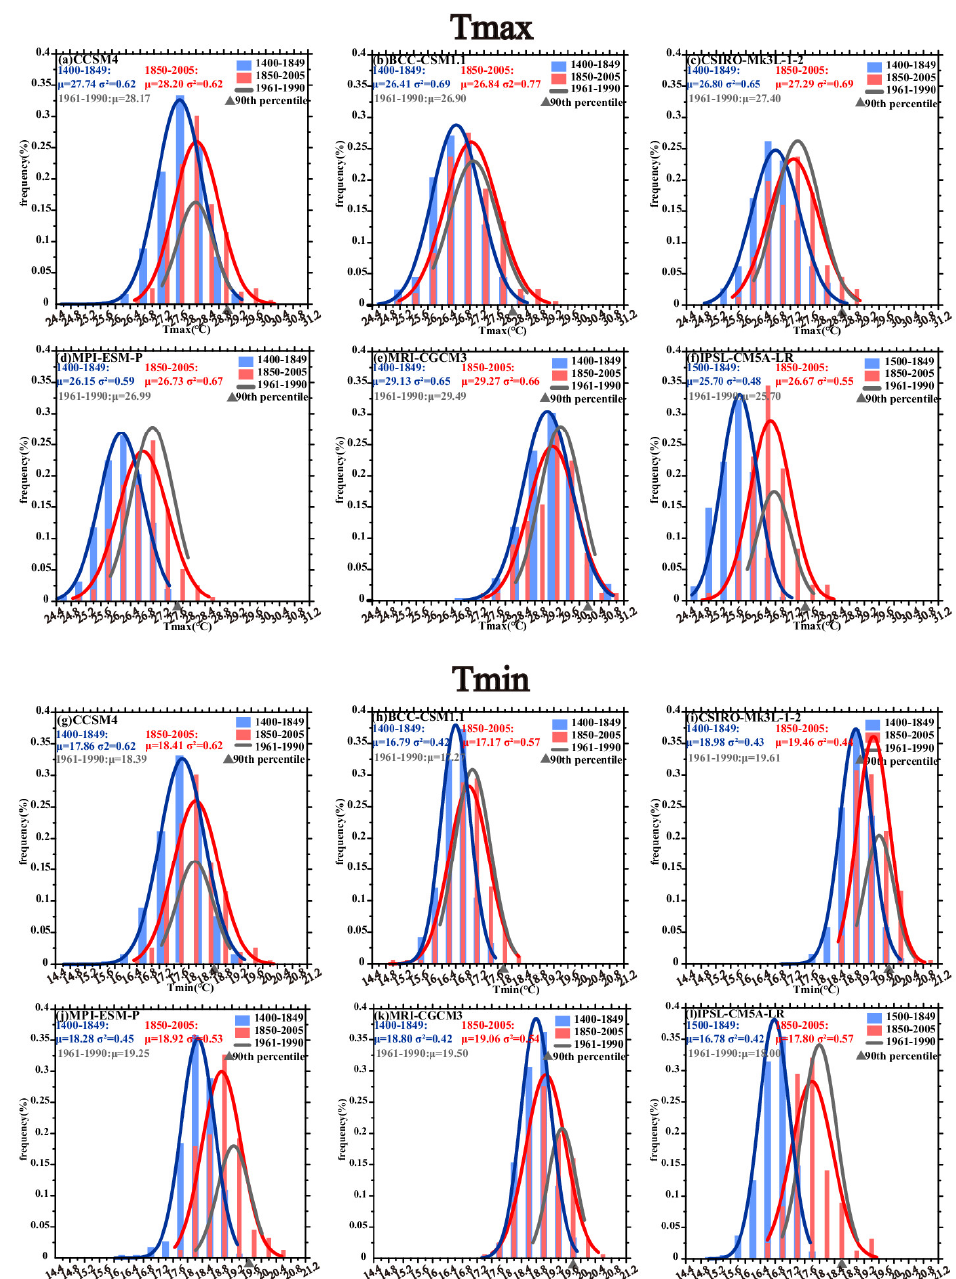
Figure 3. Histogram of simulated summer mean Tmax and Tmin before and after 1850 CE over monsoonal China. ( a , g ) CCSM4, ( b , h ) BCC-CSM1.1, ( c , i ) CSIRO-Mk3L-1–2, ( d , j ) MPI-ESM-P, ( e , k ) MRI-CGCM3, ( f , l ) IPSL-CM5A-LR. µ represents the mean and σ 2 represents the variance.